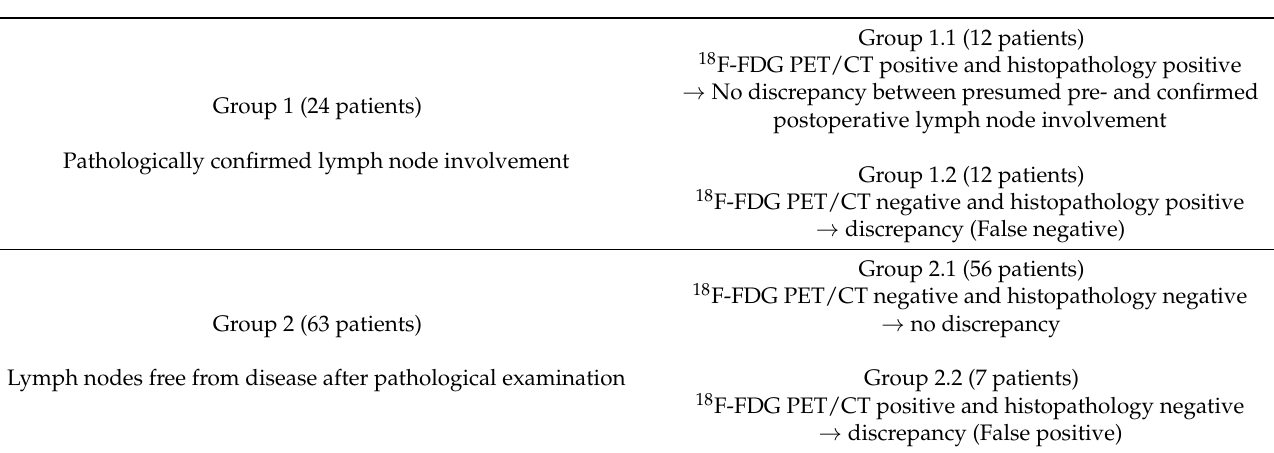
Table 2. Patient